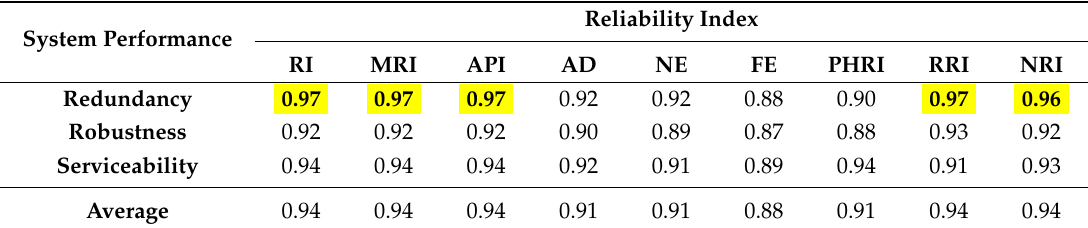
Table 8. Correlation coe ffi cients obtained by performance-based